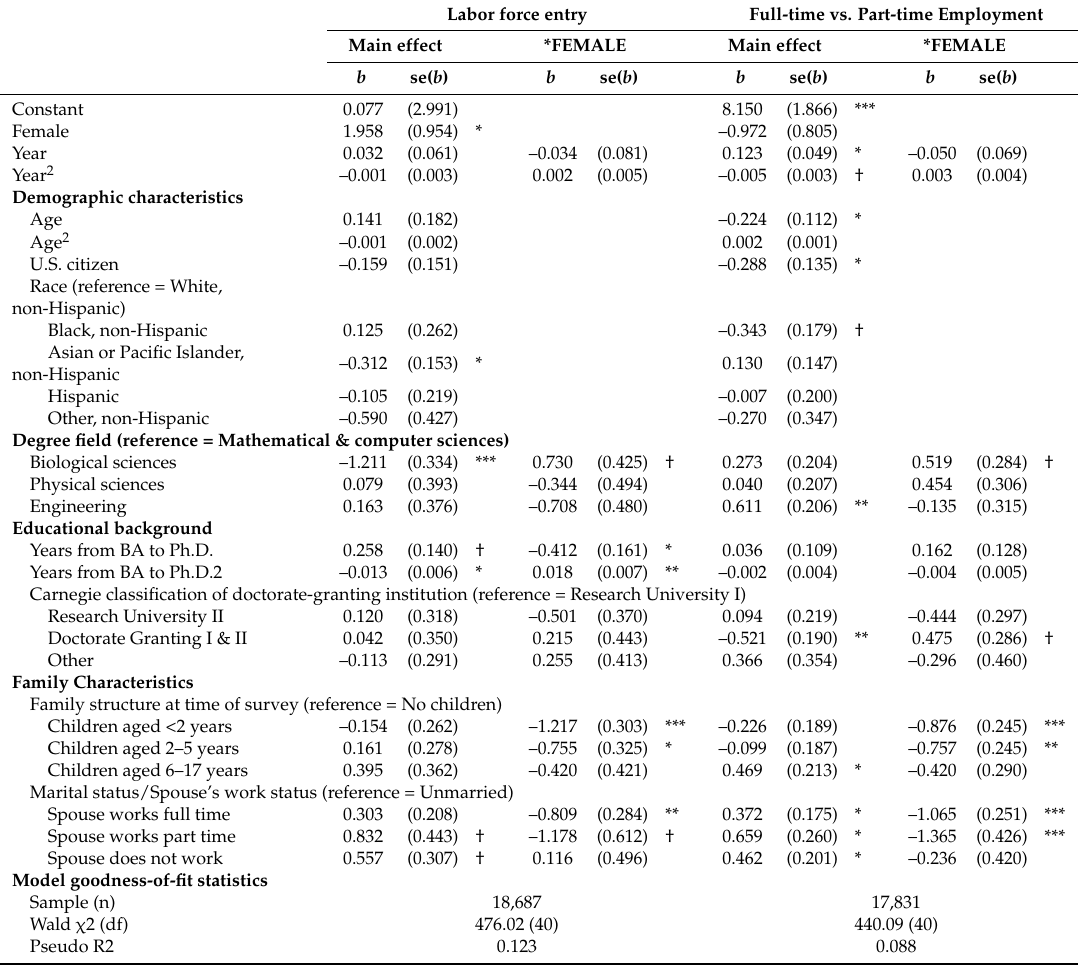
Table A2. Estimated coefficients from logit models of labor force entry and employment vs. post-doctoral